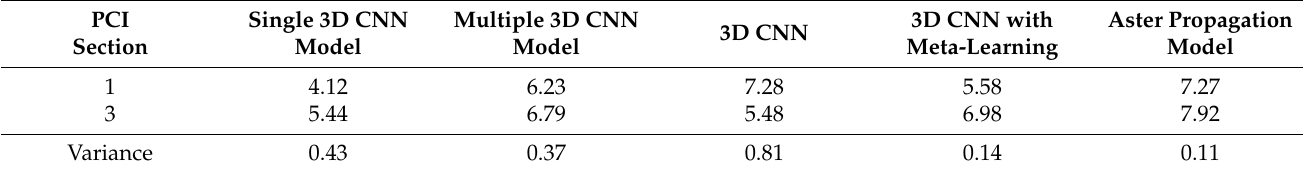
Table 10. Comparison of mean absolute error and error variance according to the PCI